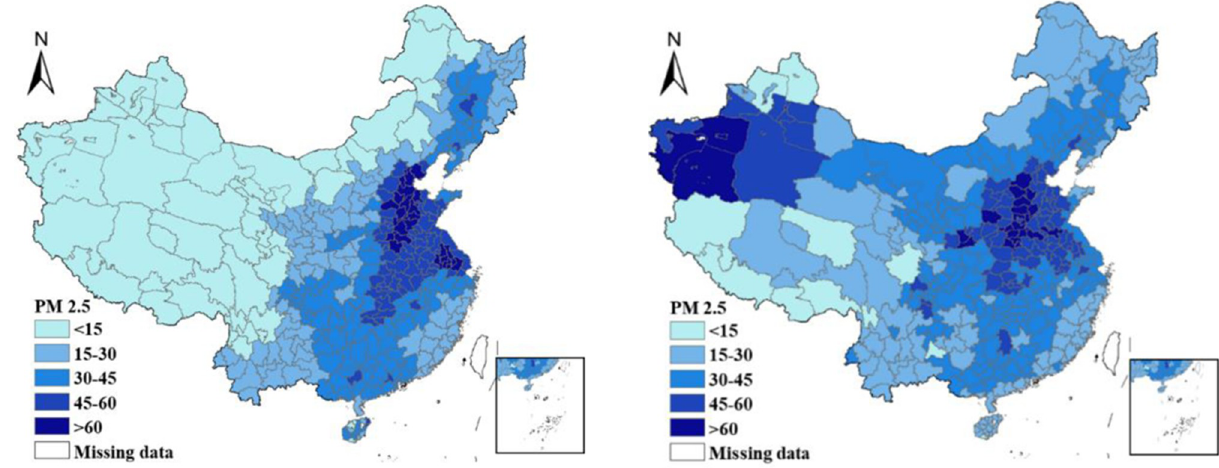
Fig 1. PM 2.5 concentration of